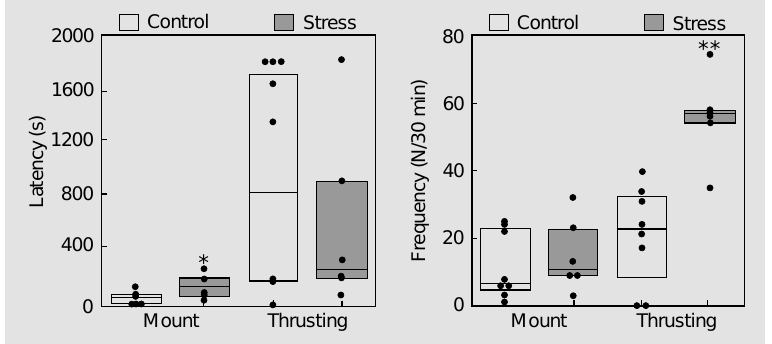
Figure 1 - Latency and frequency of mounts and thrusting in control and stressed pubertal rats with no previous sexual experience placed with adult receptive females during a 30- min session. Stress was attained by immobilization for 6 h a day from prepuberty (40 days of age) to early puberty (55 days of age). Upper and lower boundaries mark the 25 and 75%